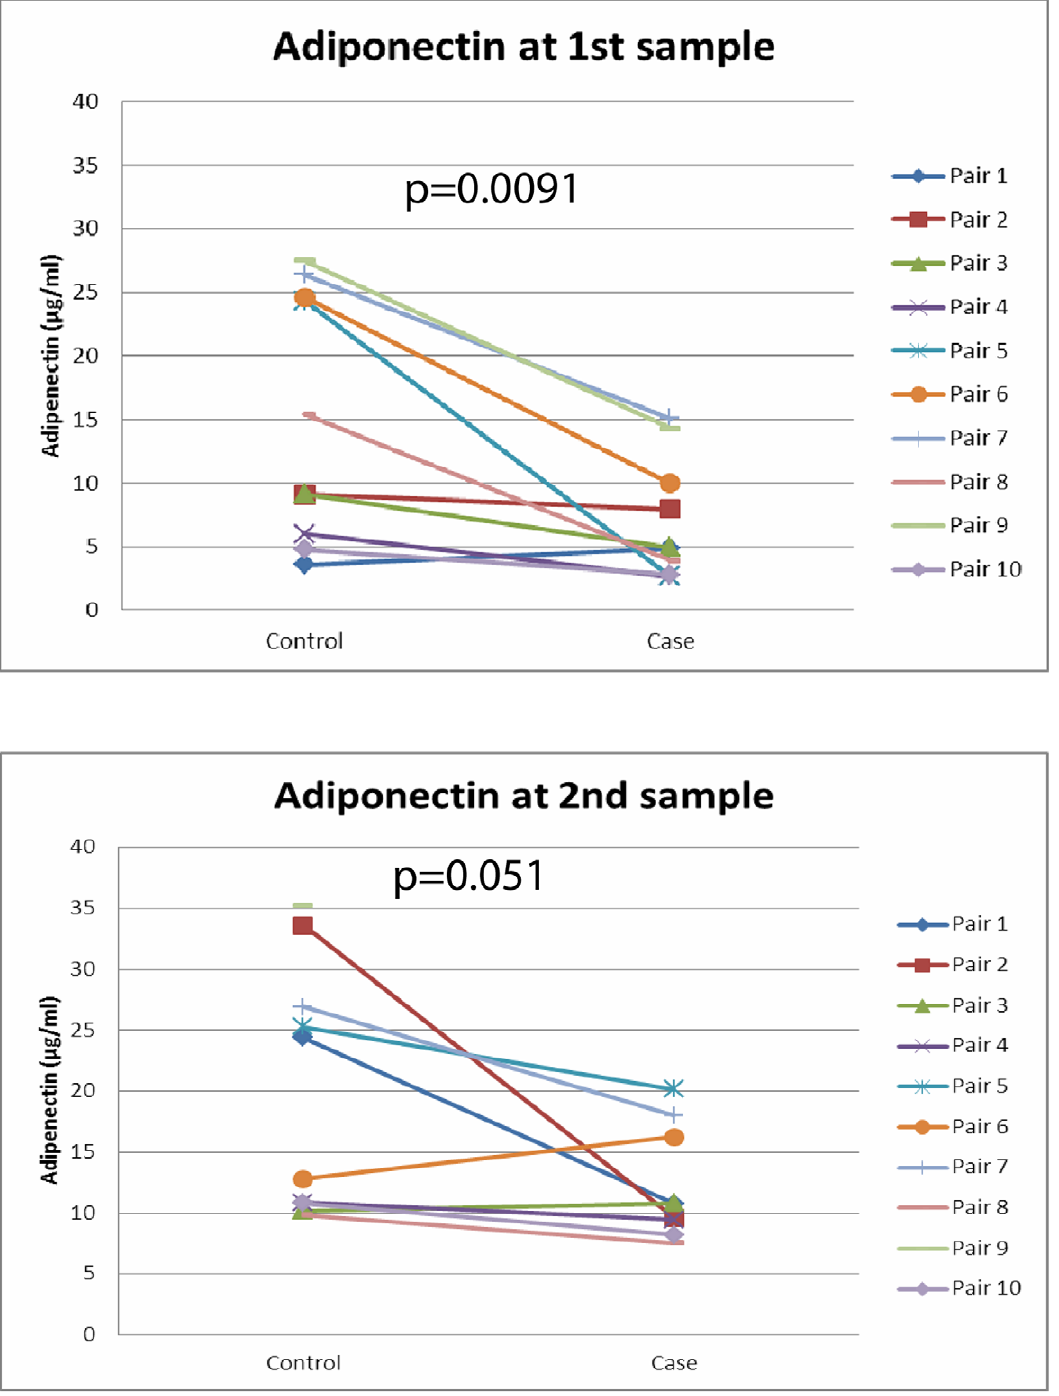
Figure 1. Serum adiponectin levels of ELGANs with and without hyperglycemia. Figure 1 indicates serum adiponectin levels both at the time of the first analysis (onset of hyperglycemia (A) and at term-equivalent age (B). Serum adiponectin concentrations of patients with hyperglycemia (case cohort) are shown on the right, those of patients with unimpaired glucose homeostasis are indicated on the left. Matched-pairs of patients are indicated by identical symbols and are connected by a solid line. In figure 1B, no second adiponectin value is indicated for the case patient of pair # 9, as no second adiponectin sample was obtained for this patient. doi:10.1371/journal.pone.0038481.g001 patients. In this context, it is also important to note that we did not attributed to the age-dependent rise in circulating adiponectin observe an absolute adiponectin cutoff-level below which hyper- concentrations, due to which adiponectin cut-off values may differ glycemia universally occured. This phenomenon is most likely depending on patients’ age. This hypothesis is supported by the